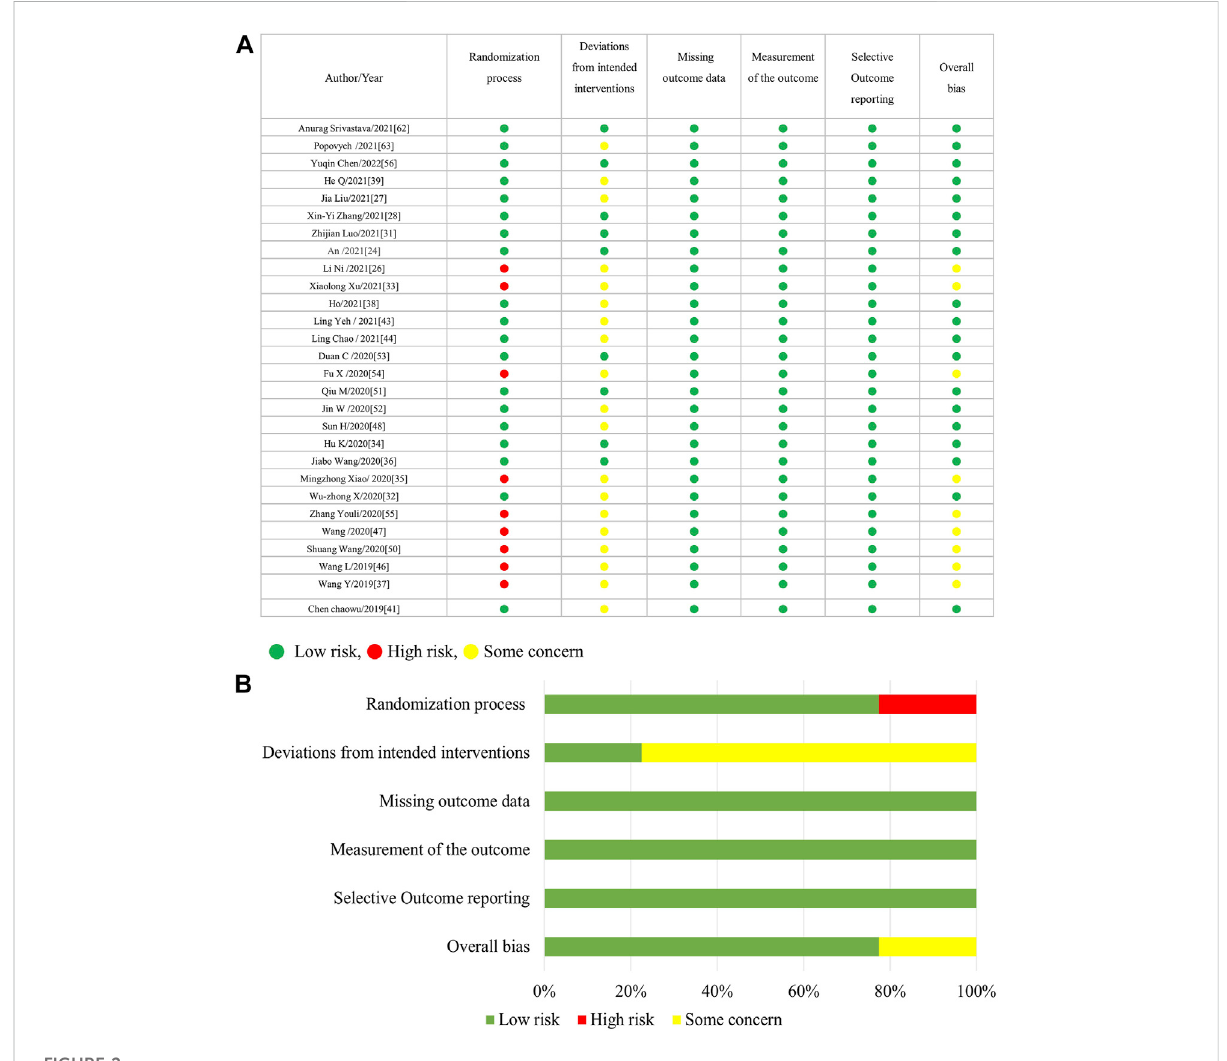
FIGURE 2 (A) : Risk of bias summary (ROB2). (B) : Risk of bias